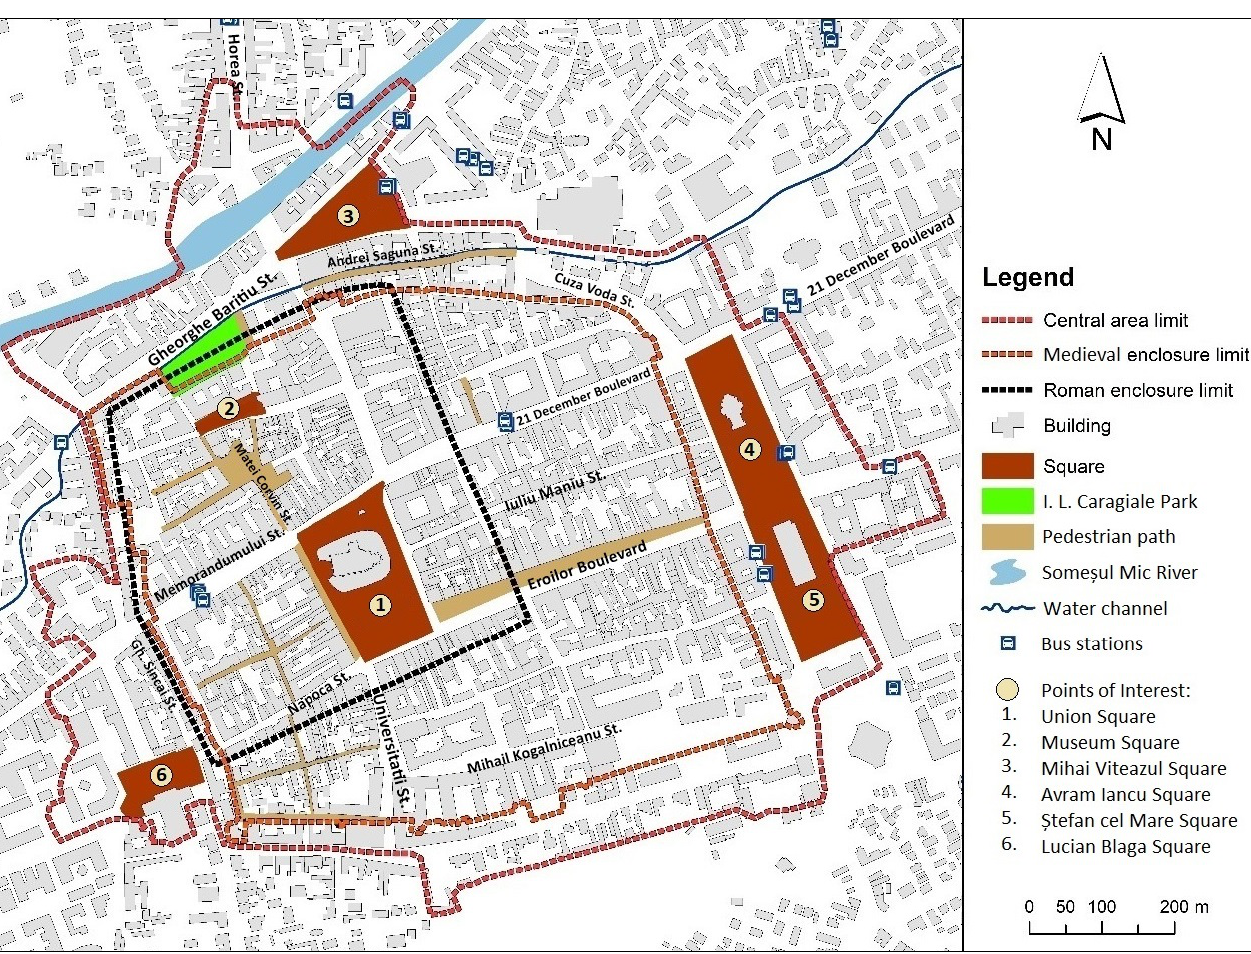
Figure 1: Setting out Cluj-Napoca central area and its squares Cartography: Emanuel-Cristian ADOREAN,